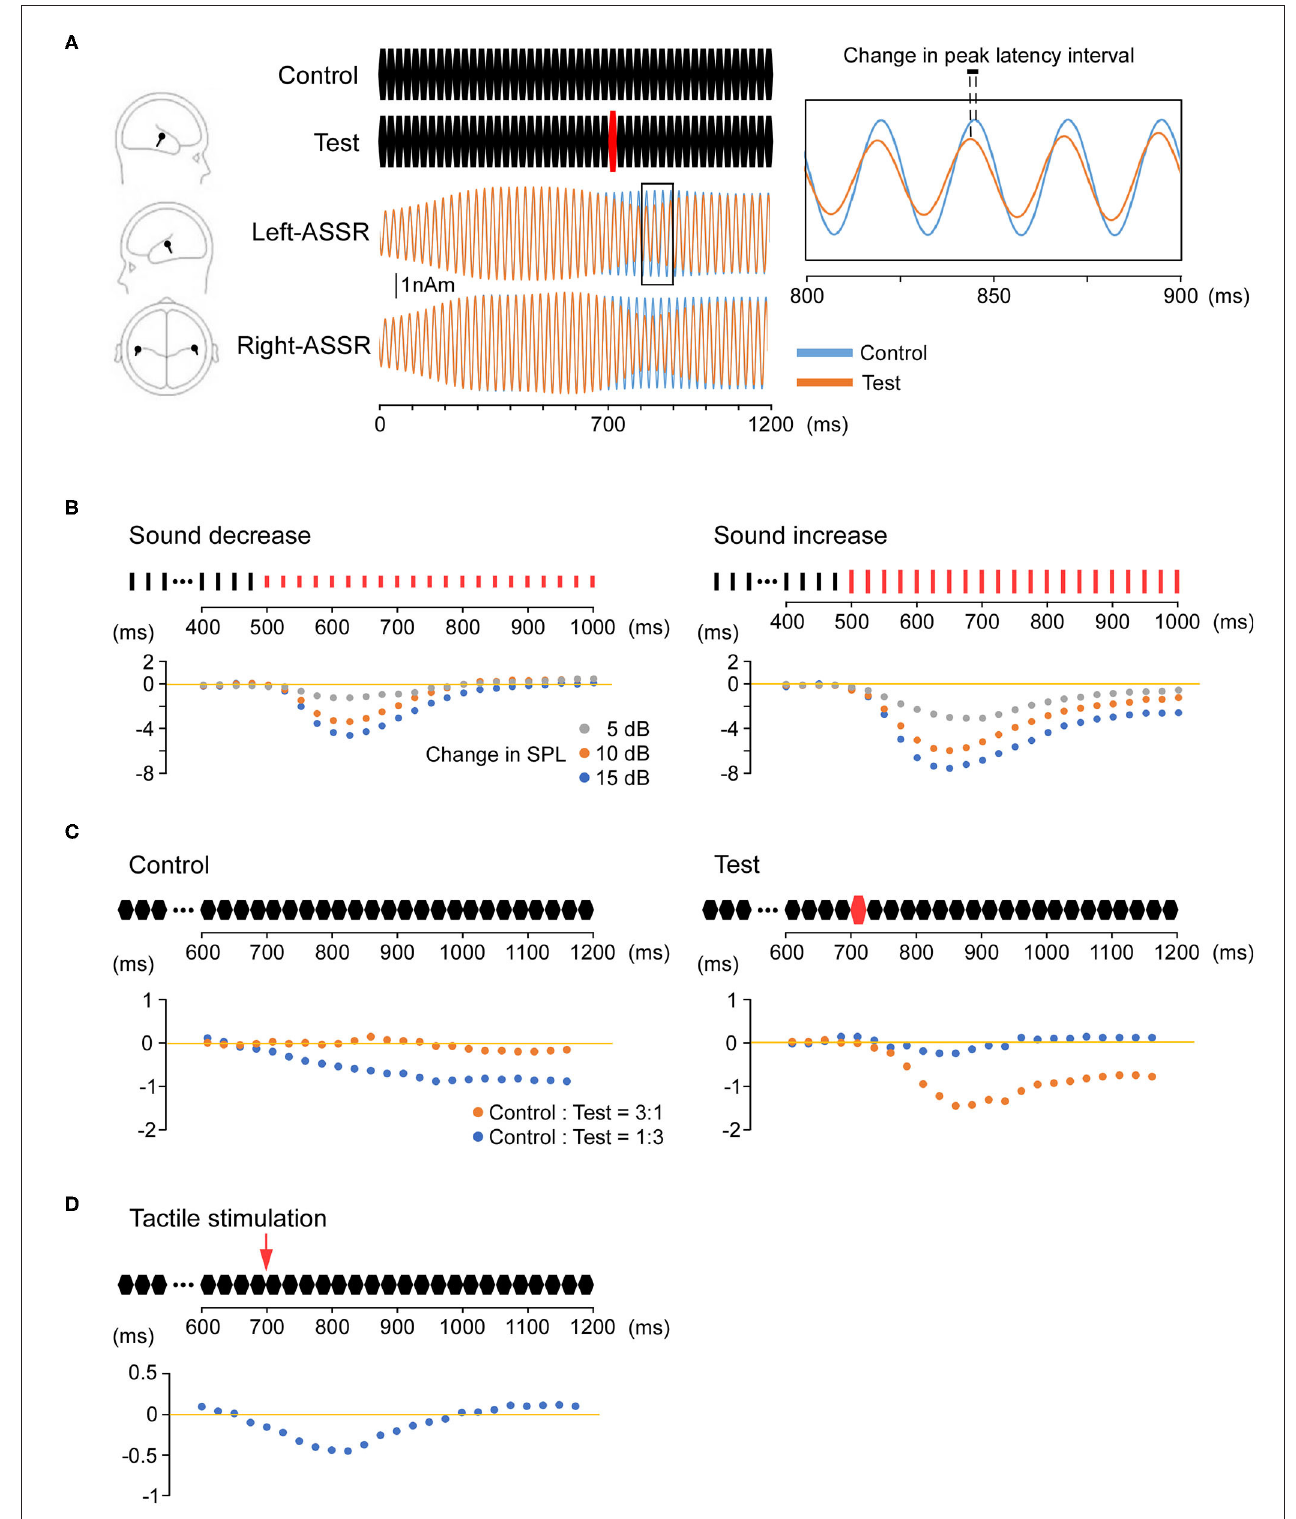
FIGURE 1 | Phase resetting of the auditory steady-state response (ASSR). (A) Modulation of the ASSR by stimulus intensity (sound pressure). Repeated presentation of a 25-ms pure tone (upper middle) elicits the 40-Hz ASSR. An abrupt increase in sound pressure at 700ms causes a reduction in amplitude and